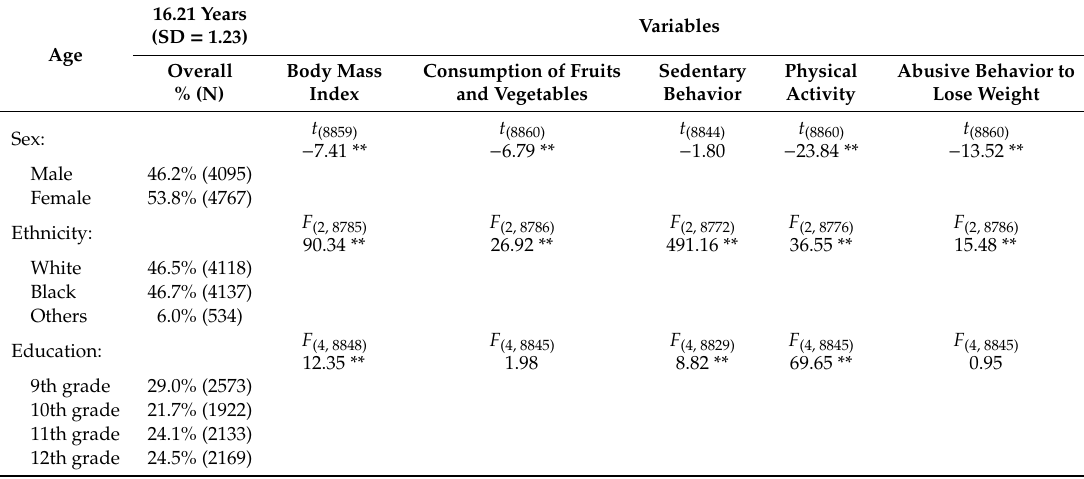
Table 1. Description of the participants and their nutrition- and physical activity-related behaviors.